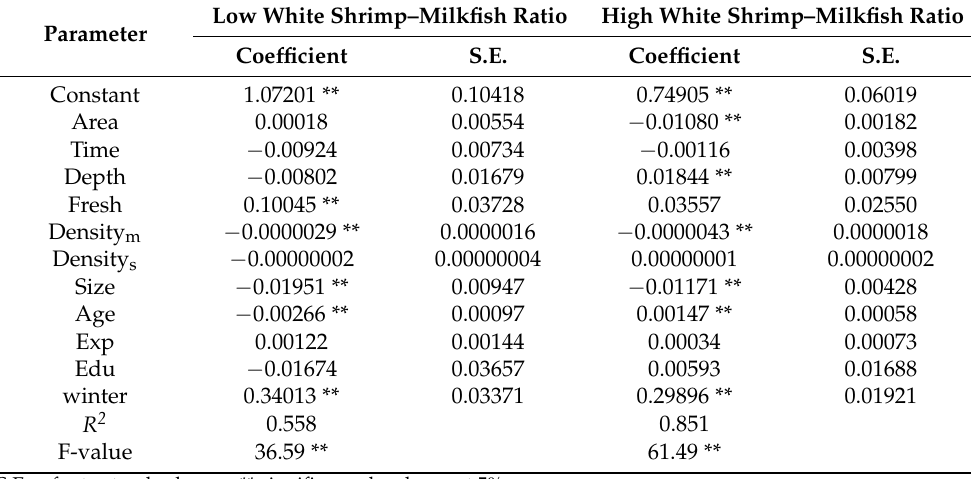
Table 7. Coefficient estimates of overall scale economies’ determinant regression for low and high white shrimp–milkfish ratio. Low White Shrimp–Milkfish Parameter